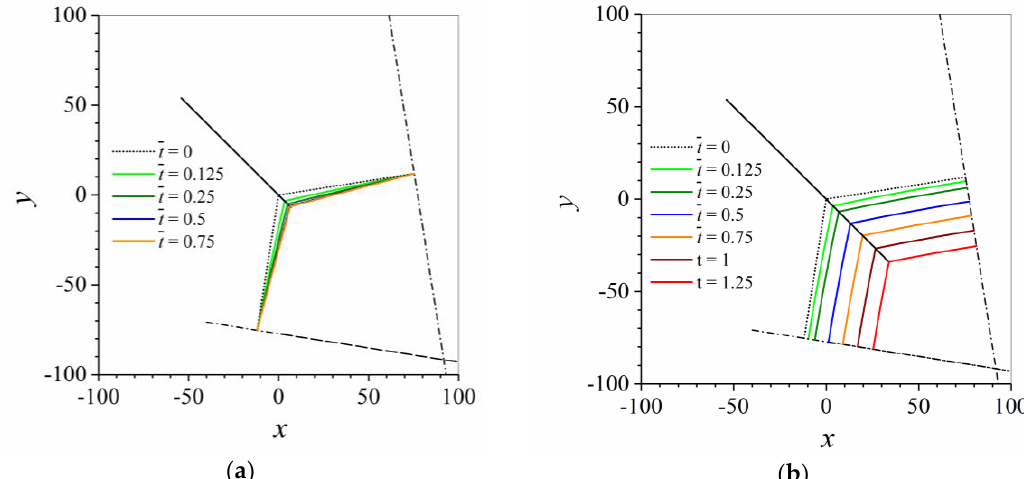
Figure 12. Evolution of the grain boundaries and the triple junction for the symmetry unit of an initially regular pentagon with Λ = 2. ( a ) Case I, ( b ) Case II.